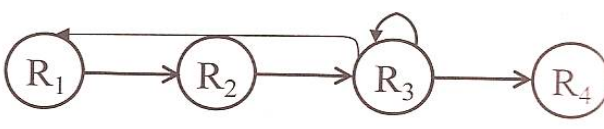
Figure 6. A simplified flow-chart of the CBR process.